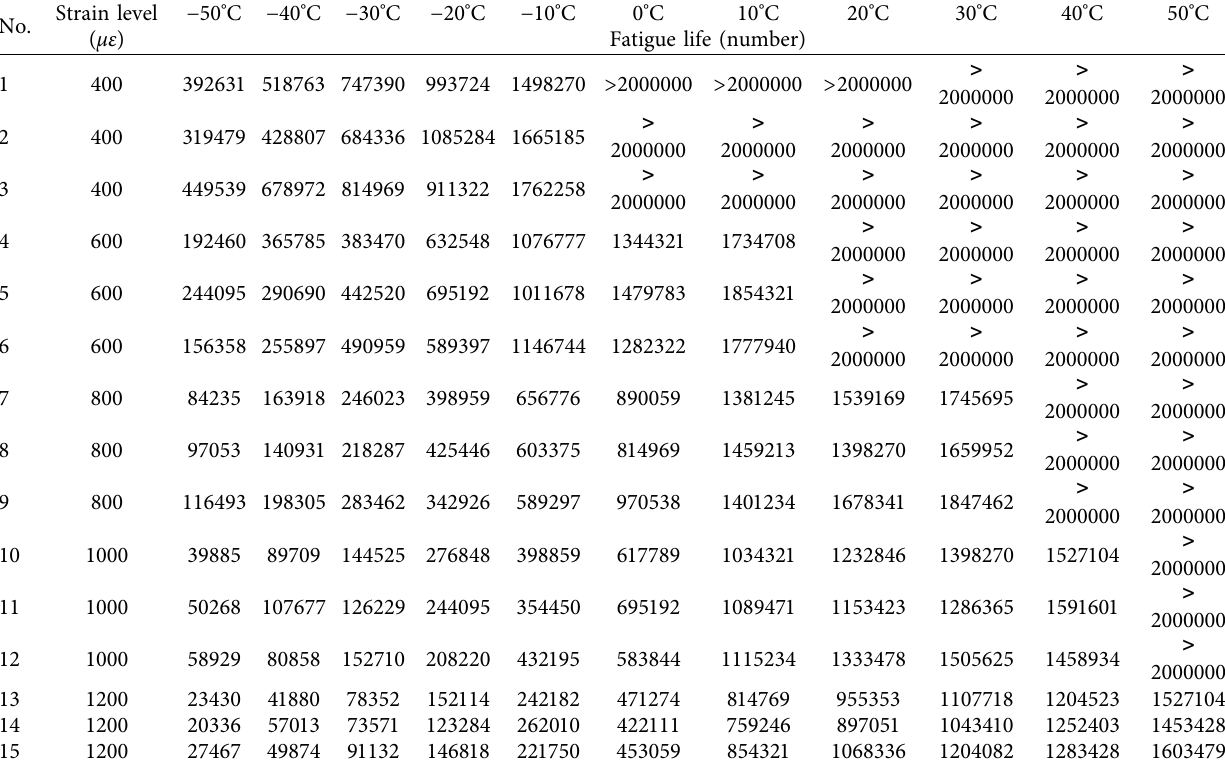
Table 6: Fatigue life of polyurethane cement specimens at different